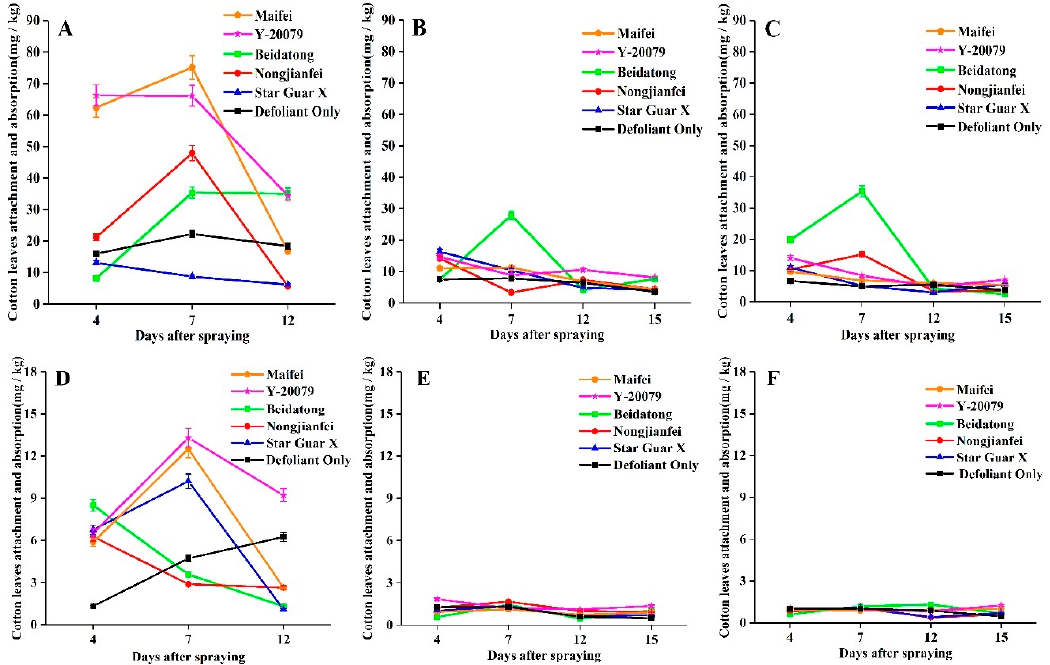
Figure 6. Effect of aviation spray adjuvants on attachment and absorption of thidiazuron and diuron on cotton leaf sprayed. Thidiazuron: ( A ) upper, ( B ) middle and ( C ) lower layers; Diuron: ( D ) upper, canopy of cotton was over 85% although this sample was not